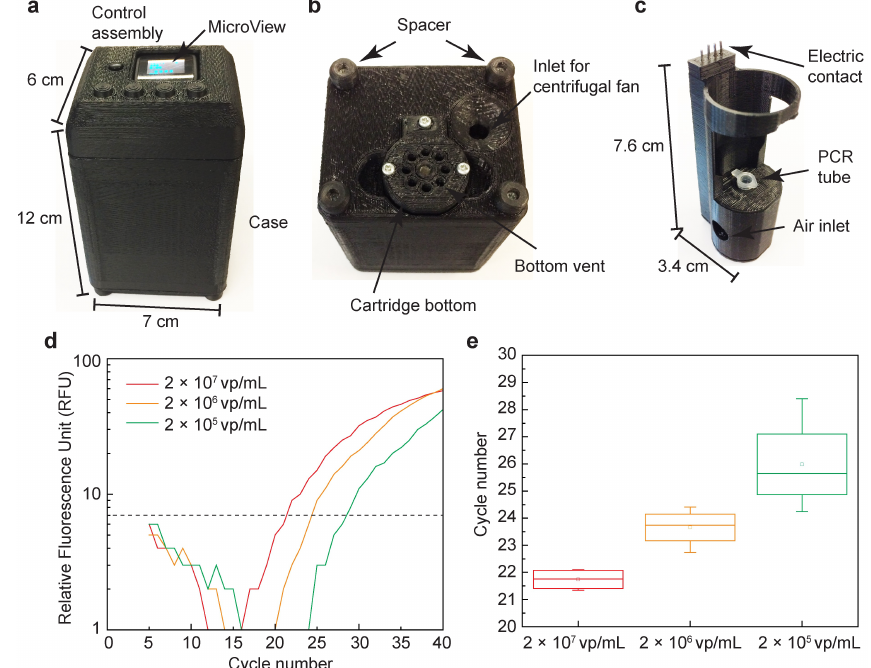
Figure 6. 3D printed real-time PCR machine for lentivirus detection and quantification. The small device is capable of quantifying different viral loads using fluorescence measurements of DNA. ( a ) Top view of the qPCR device with MicroView screen showing the status of the amplification cycle and fluorescence reading. ( b ) Bottom view of the qPCR machine displaying cartridge bottom, spacer, and inlet for centrifugal fan. ( c ) Dimensions of the cartridge. ( d ) Fluorescence measurement illustrating change in intensity for different virus concentrations. ( e ) Measured Cq for three concentrations of target DNA. Reprint from